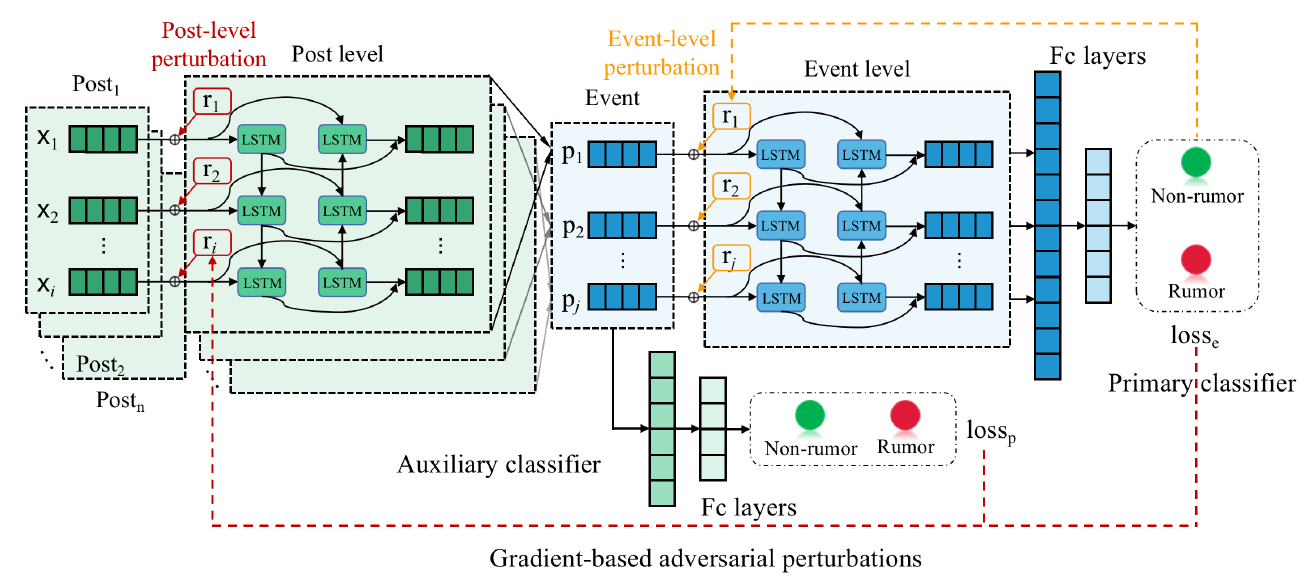
Figure 3. The architecture of the proposed model